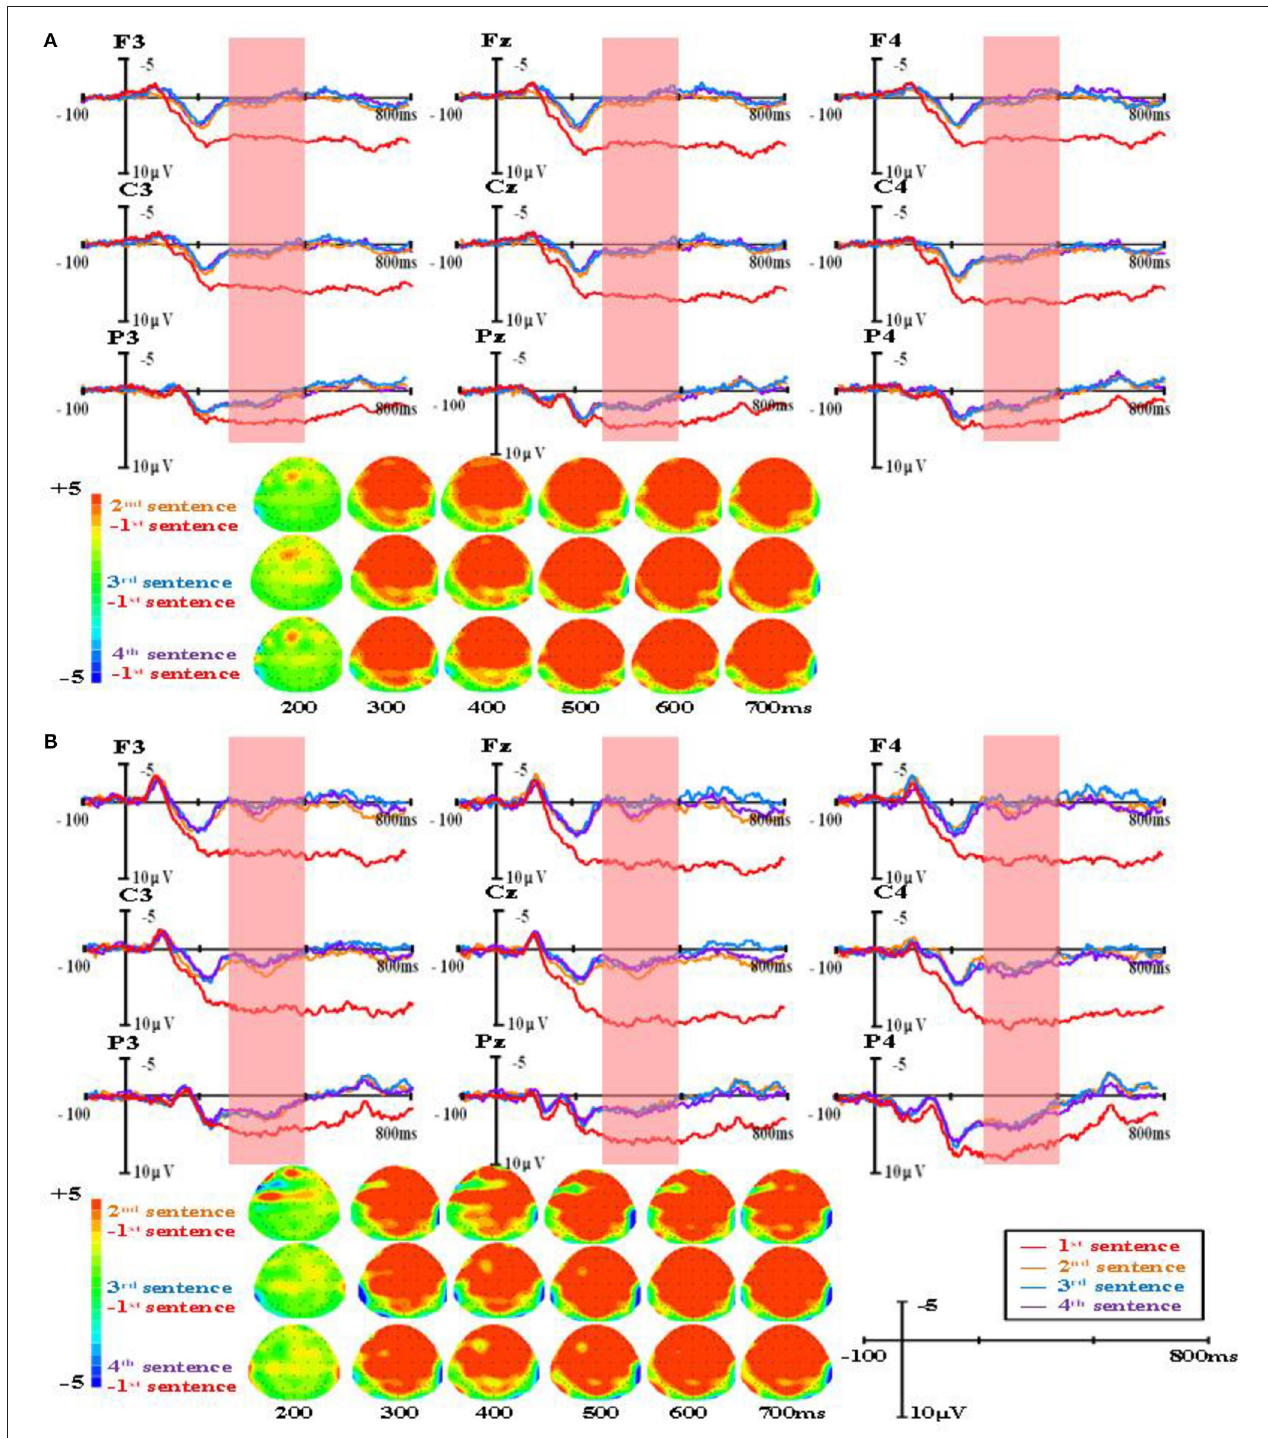
FIGURE 2 | The group-level average waveforms and scalp distribution elicited by real words of four sentences (R condition) for higher proficiency (A) and lower proficiency participants (B) .